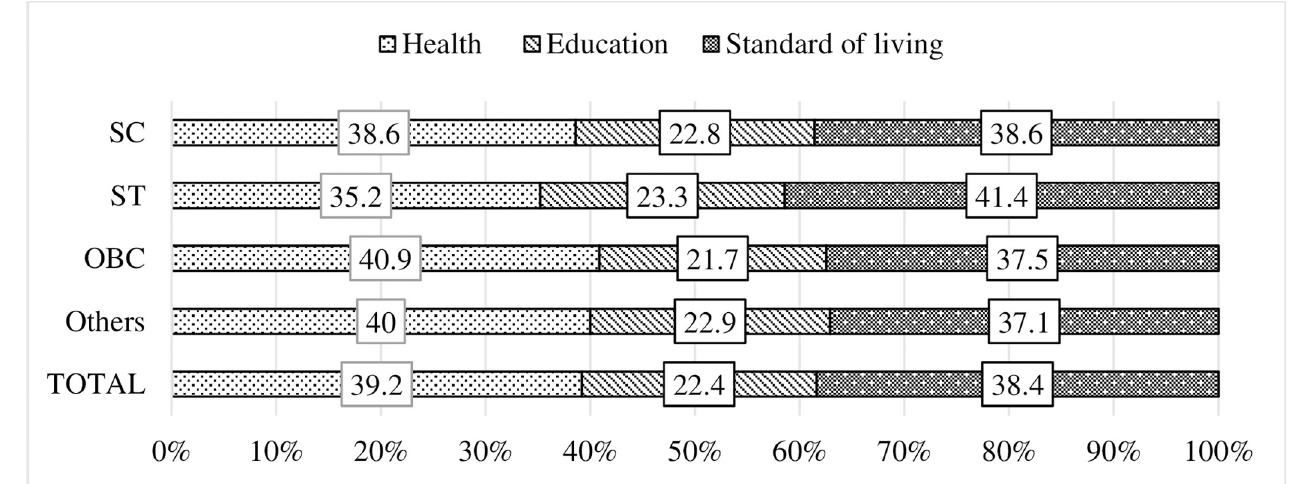
Fig 3. Decomposition of multidimensional poverty index by the three dimensions and by the social groups.